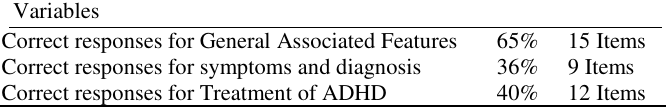
Table 2 Responses of teachers: Knowledge of ADHD